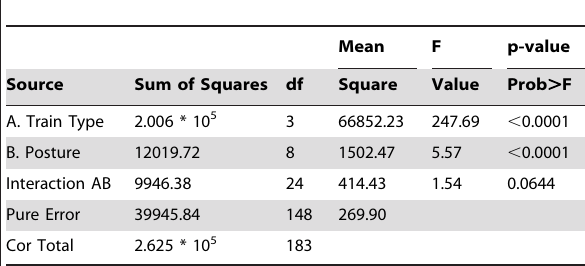
Table 1. Analysis of Variance for 2-Factor Factorial